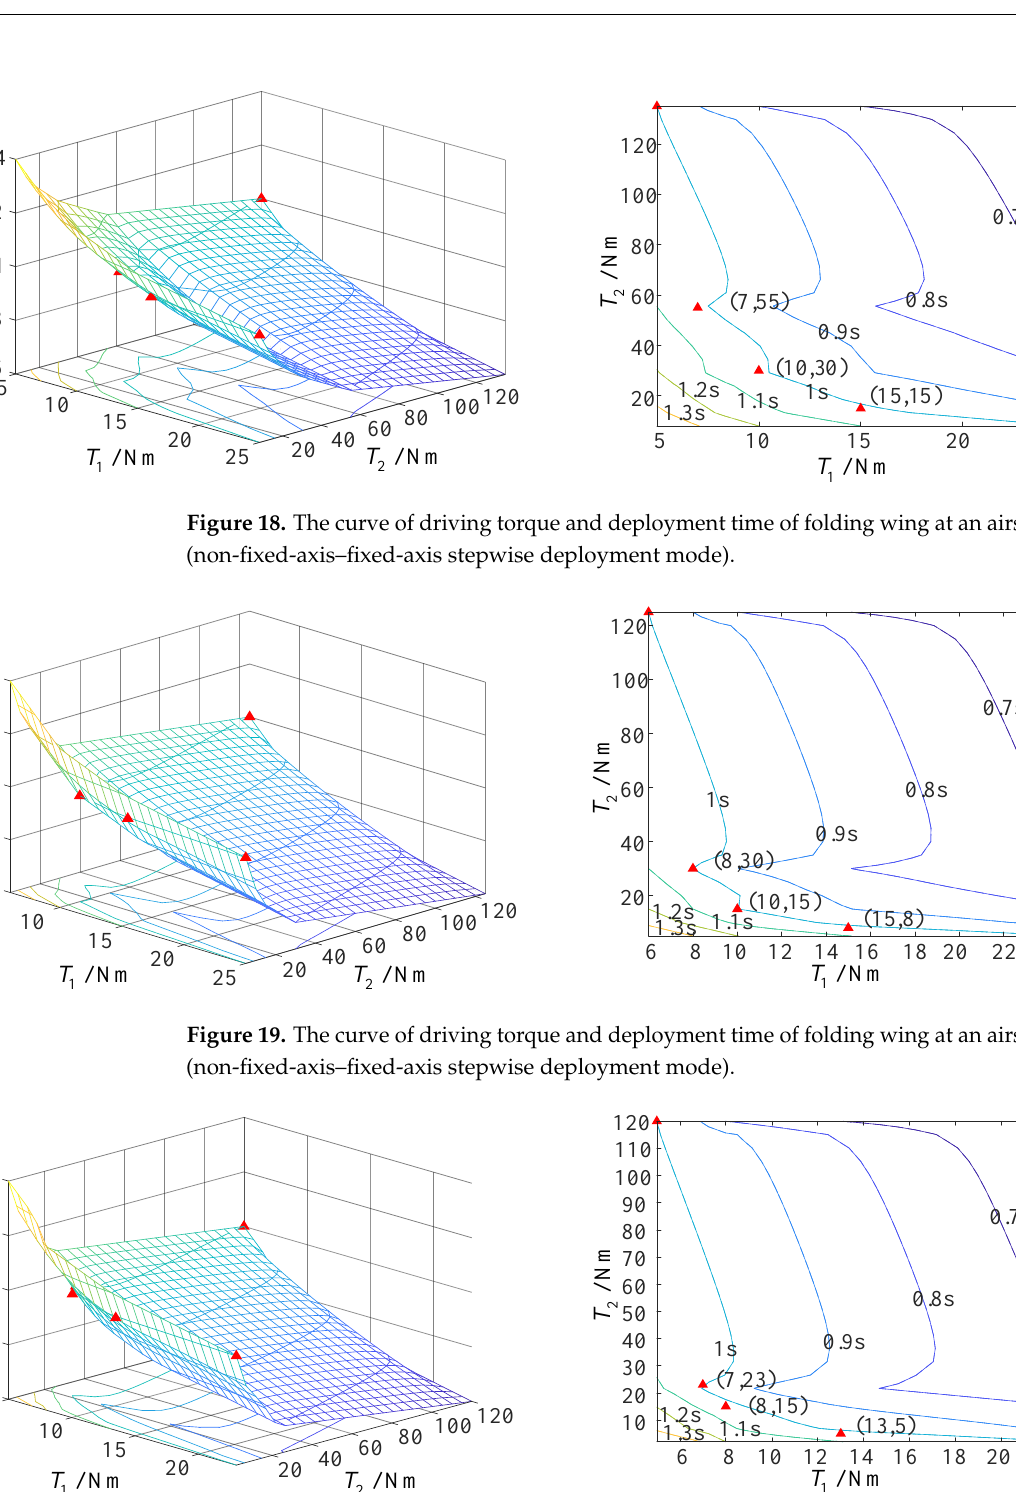
Figure 20. The curve of driving torque and deployment time of folding wing at an airspeed of 50 m/s (non-fixed-axis – fixed-axis stepwise deployment mode). When the fixed-axis – non-fixed-axis stepwise deployment mode is adopted and the airspeed is 10 m/s, the minimum driving torque required by axis 1 to complete the action is 25 Nm, and that required by axis 2 to complete the action is 25 Nm, on the premise that the folding wing can complete the action within 1 s, as shown in Figure 21.